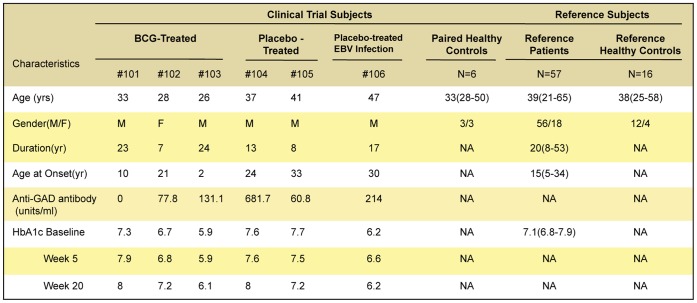
Clinical characteristics of groups of clinical trial subjects and reference subjects.